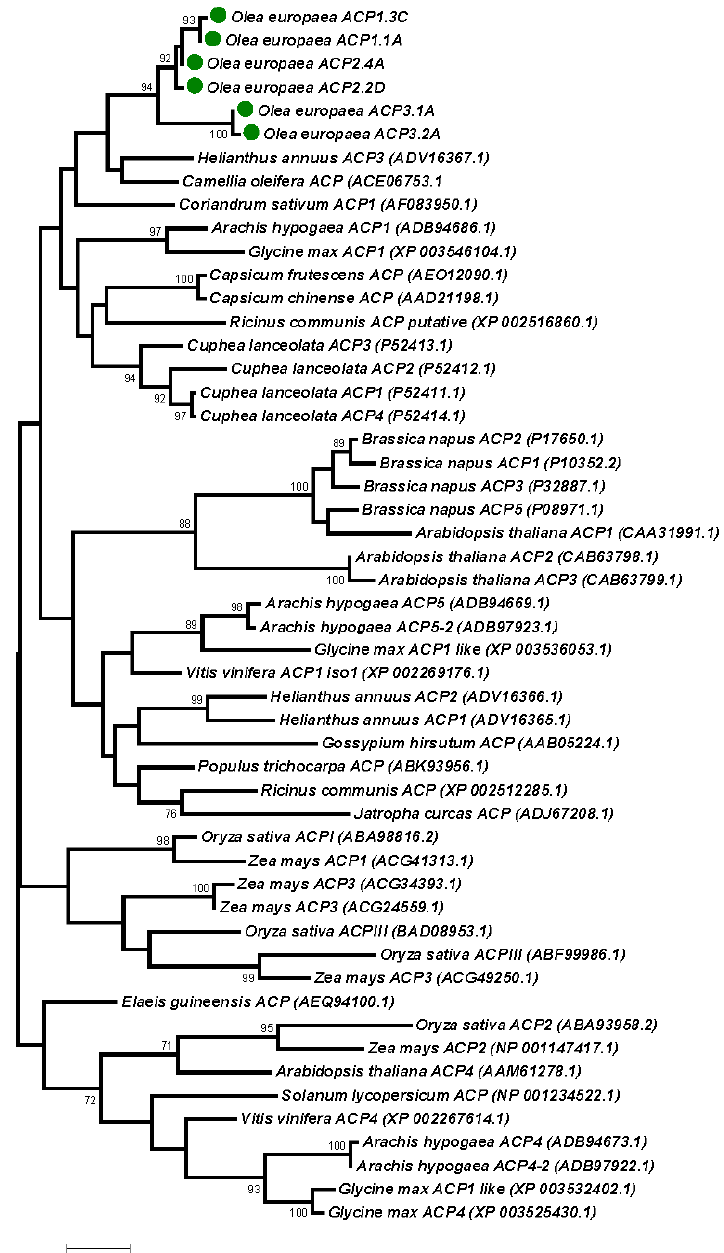
Figure 2. Comparative Neighbor Joining phylogenetic tree of orthologous genes for the pathway of